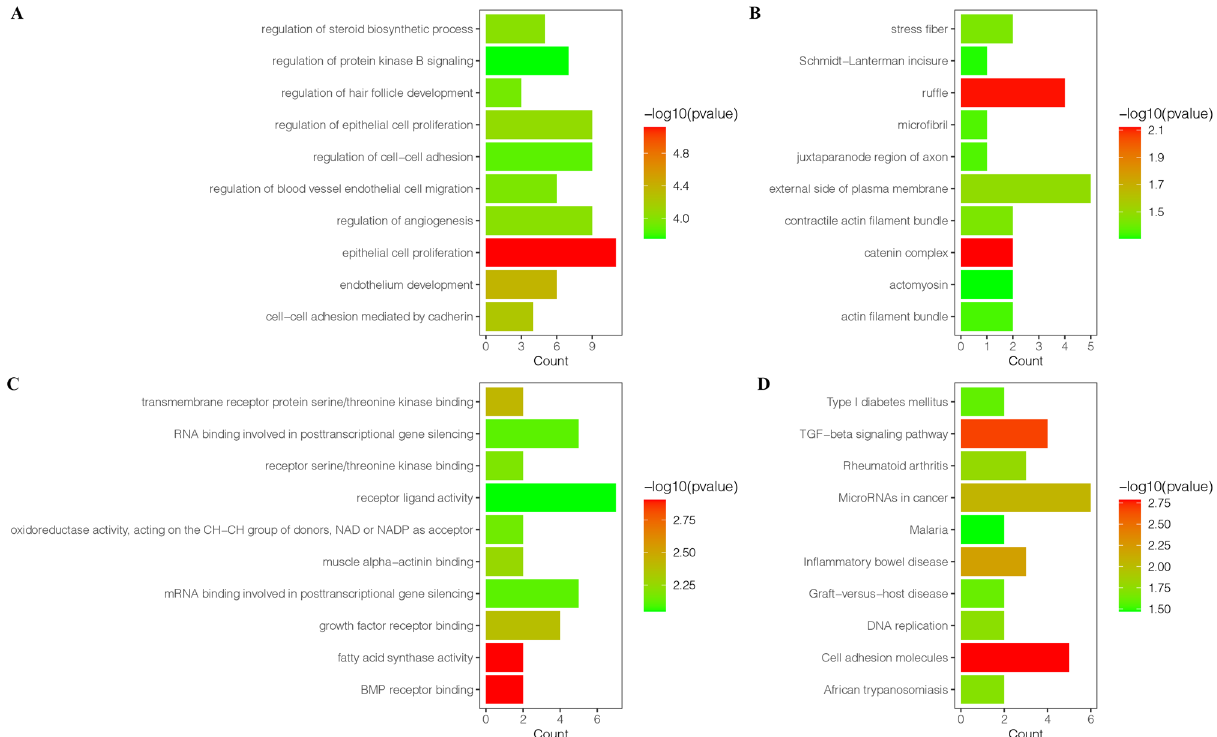
Figure 4. Enrichment analysis of the survival-associated RNAs. ( A ) Bar plot of enriched GO BP terms. ( B ) Bar plot of enriched GO CC terms. ( C ) Bar plot of enriched GO MF terms. ( D ) Bar plot of enriched KEGG